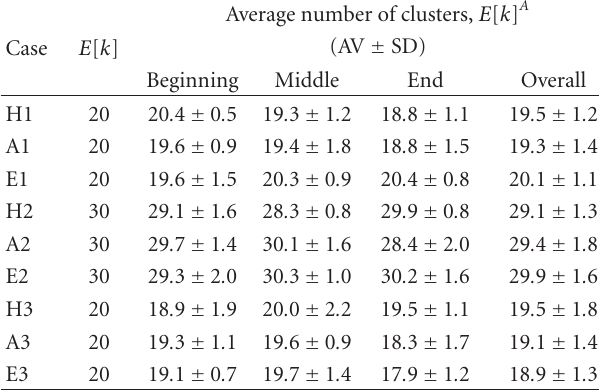
Table 2: Applicability of the proposed technique equally among HEED, ANTCLUST, and EDCR